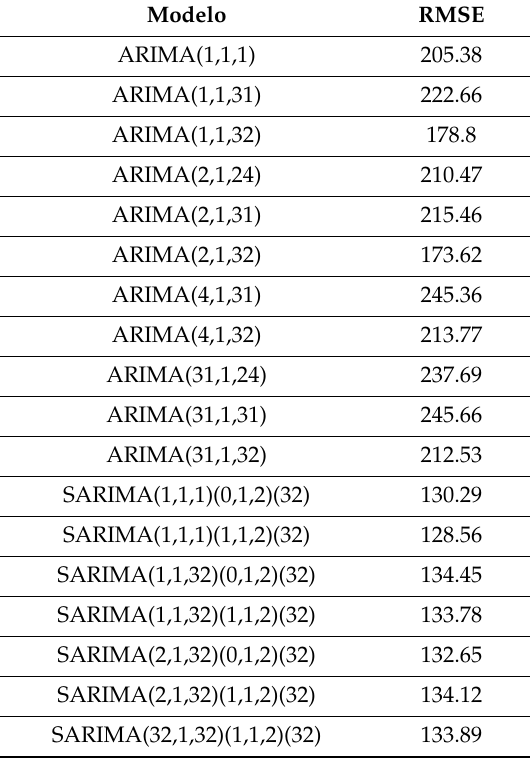
Table 4. RMSE (Root-Mean-Square Error) value for various models.